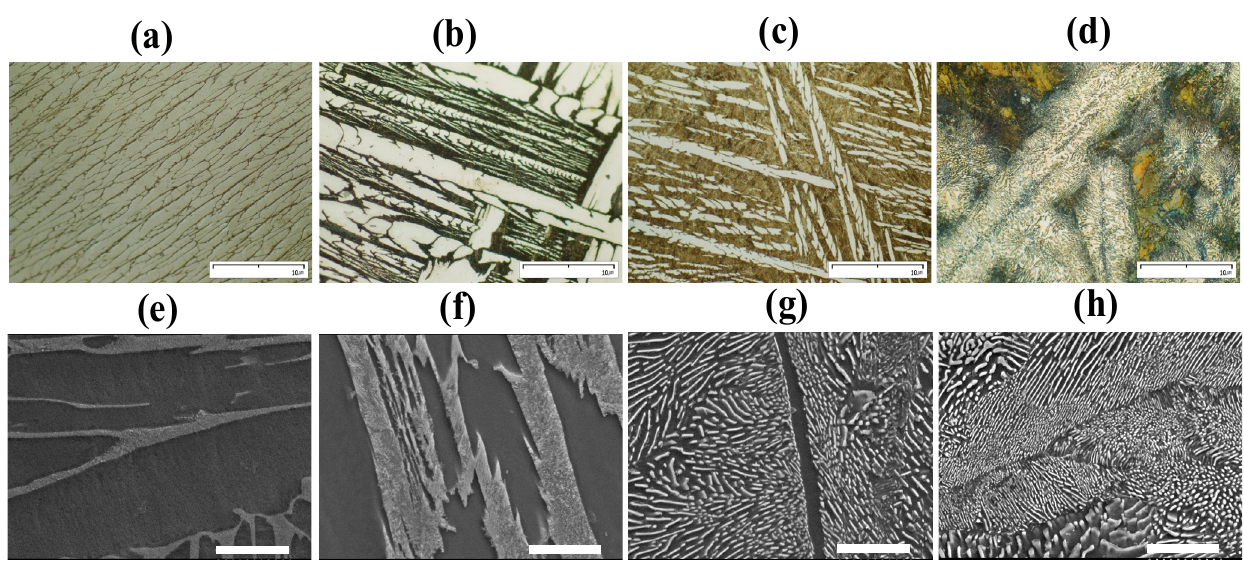
Figure 2. Optical micrographs (×400) of Ti-xPt alloys: ( a ) Ti-5Pt; ( b ) Ti-10Pt; ( c ) Ti-15Pt; ( d ) Ti-20Pt; and SEM micrographs of Ti-xPt alloys using secondary electron detector: ( e ) Ti-5Pt; ( f ) Ti-10Pt; ( g ) Ti-15Pt; ( h ) Ti-20Pt. Scale bar = 10